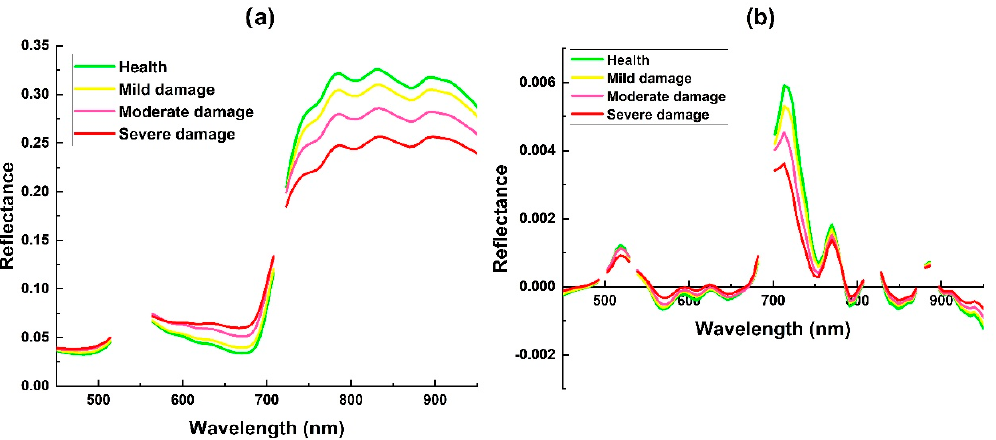
Figure 12. Comparison of sensitive bands of spectral reflectance and the first derivative of Pinus yunnanensis with different damage degrees by Tomicus (Needle). ( a ) Spectral reflectance of the needle; ( b ) Spectral first derivative of the needle.